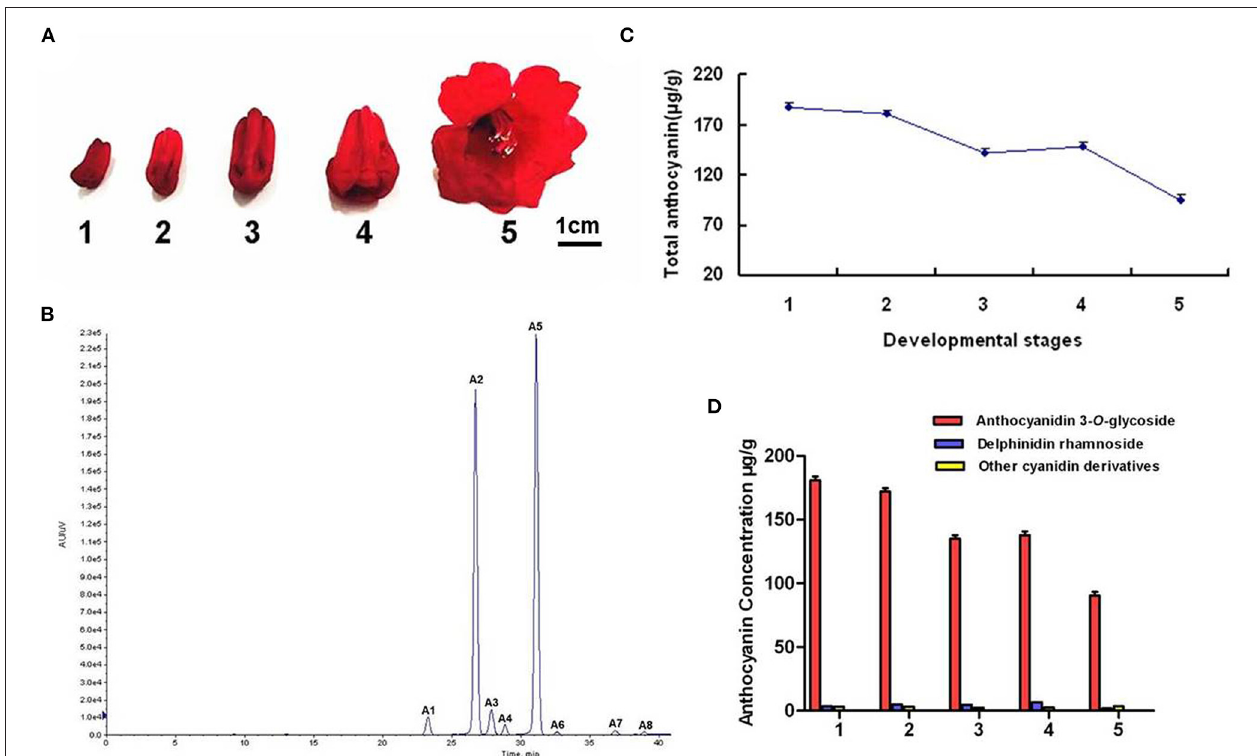
FIGURE 1 | Anthocyanin component analyses in R. delavayi flower. (A) The phenotypes of different development stage. (B) Total anthocyanin profile at different developmental stages. (C) HPLC profiles of anthocyanin. A1, delphinidin 3- O -galacoside; A2, cyanidin 3- O -galacoside; A3, delphinidin rhamnoside; A4, cyanidin 3- O -glucoside; A5, cyanidin 3- O -arabinoside; A6/A7/A8, other cyanidin derivatives. (D) The contents of different anthocyanin at five developmental